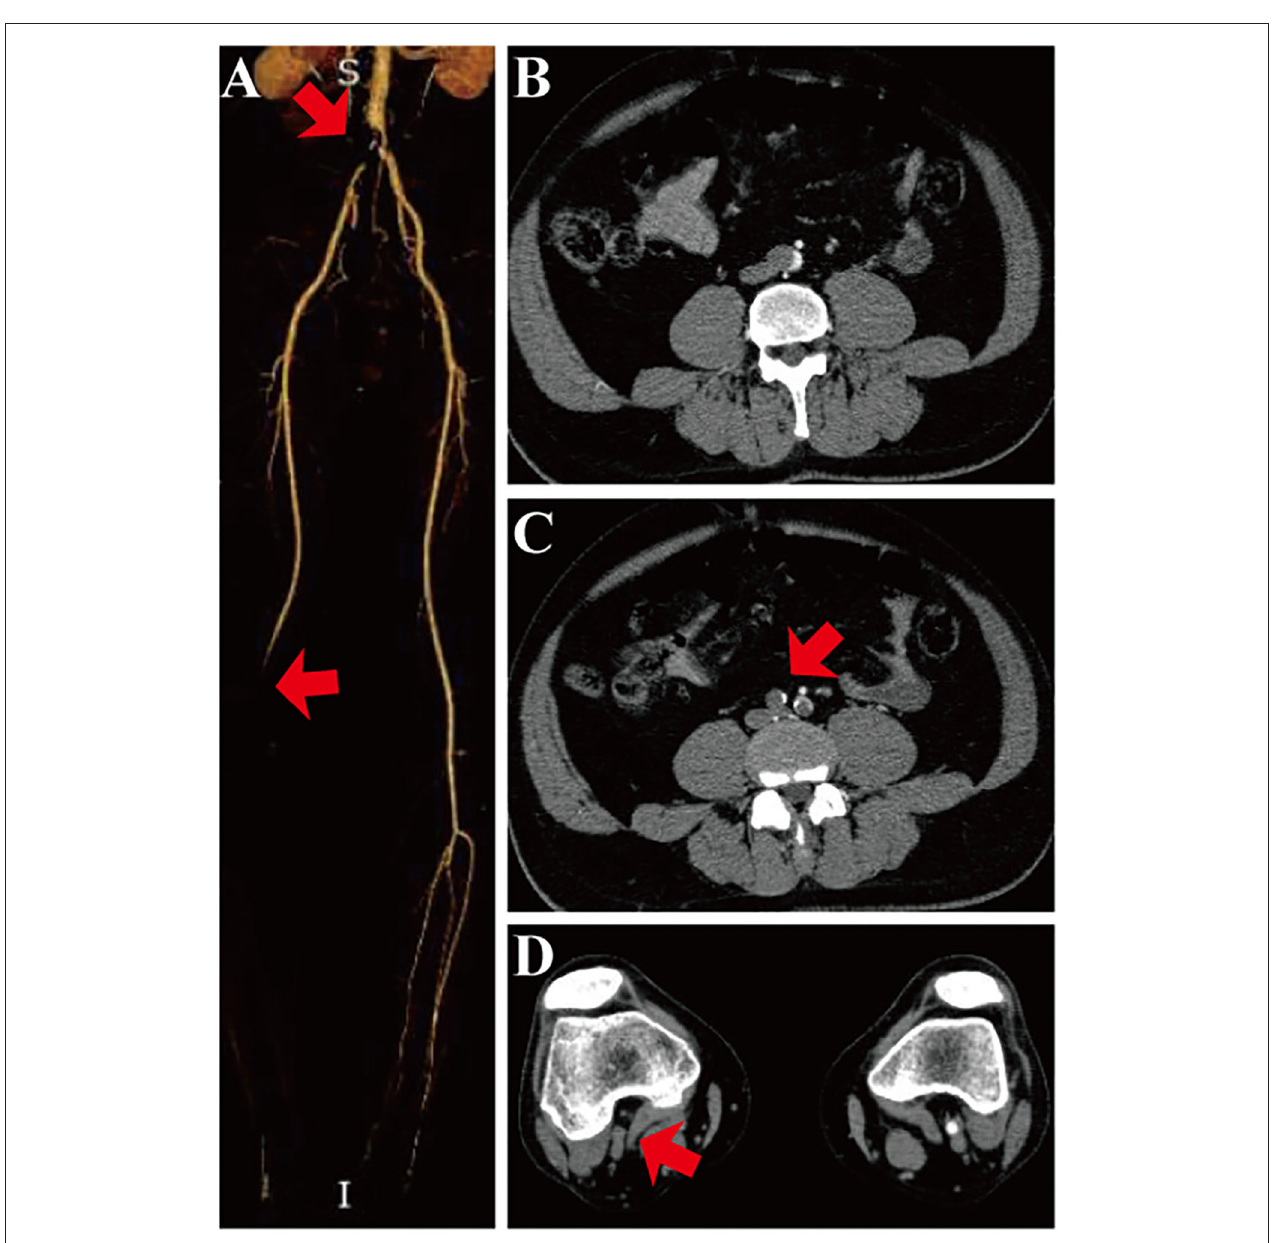
FIGURE 1 | Preoperative CTA scan of the abdominal aorta and peripheral artery. (A) Three-dimensional CTA scan shows embolism (red arrow) in the inferior segment of the abdominal aorta, bilateral common iliac artery, and the right popliteal artery. (B) Cross-section of CTA shows embolism in the inferior segment of the abdominal aorta. (C) Cross-section of CTA shows embolism in the bilateral common iliac artery (red arrow). (D) Cross-section of CTA shows embolism in the right popliteal artery (red arrow).